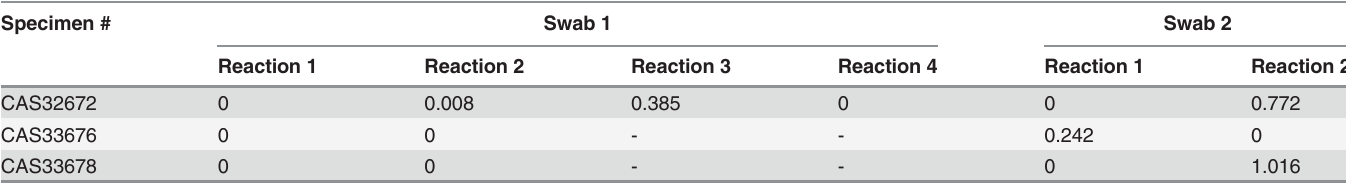
Table 2. Quantitiative PCR (qPCR) results of frog specimens that screened positive for Batrachochytrium dendrobatidis ( Bd ) infection. Specimen